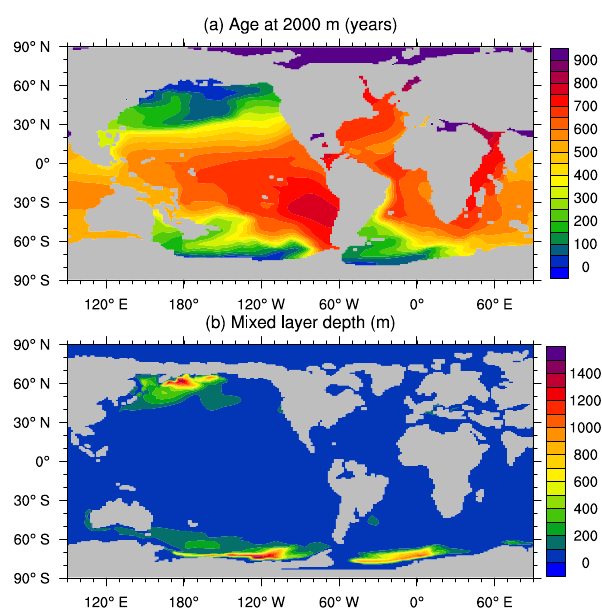
Figure 8. (a) Age tracer at 2000m depth and (b) mixed layer depth. Note that the age scale is saturated in the Arctic, where the strong halocline prevents ventilation and ages are greater than 3000